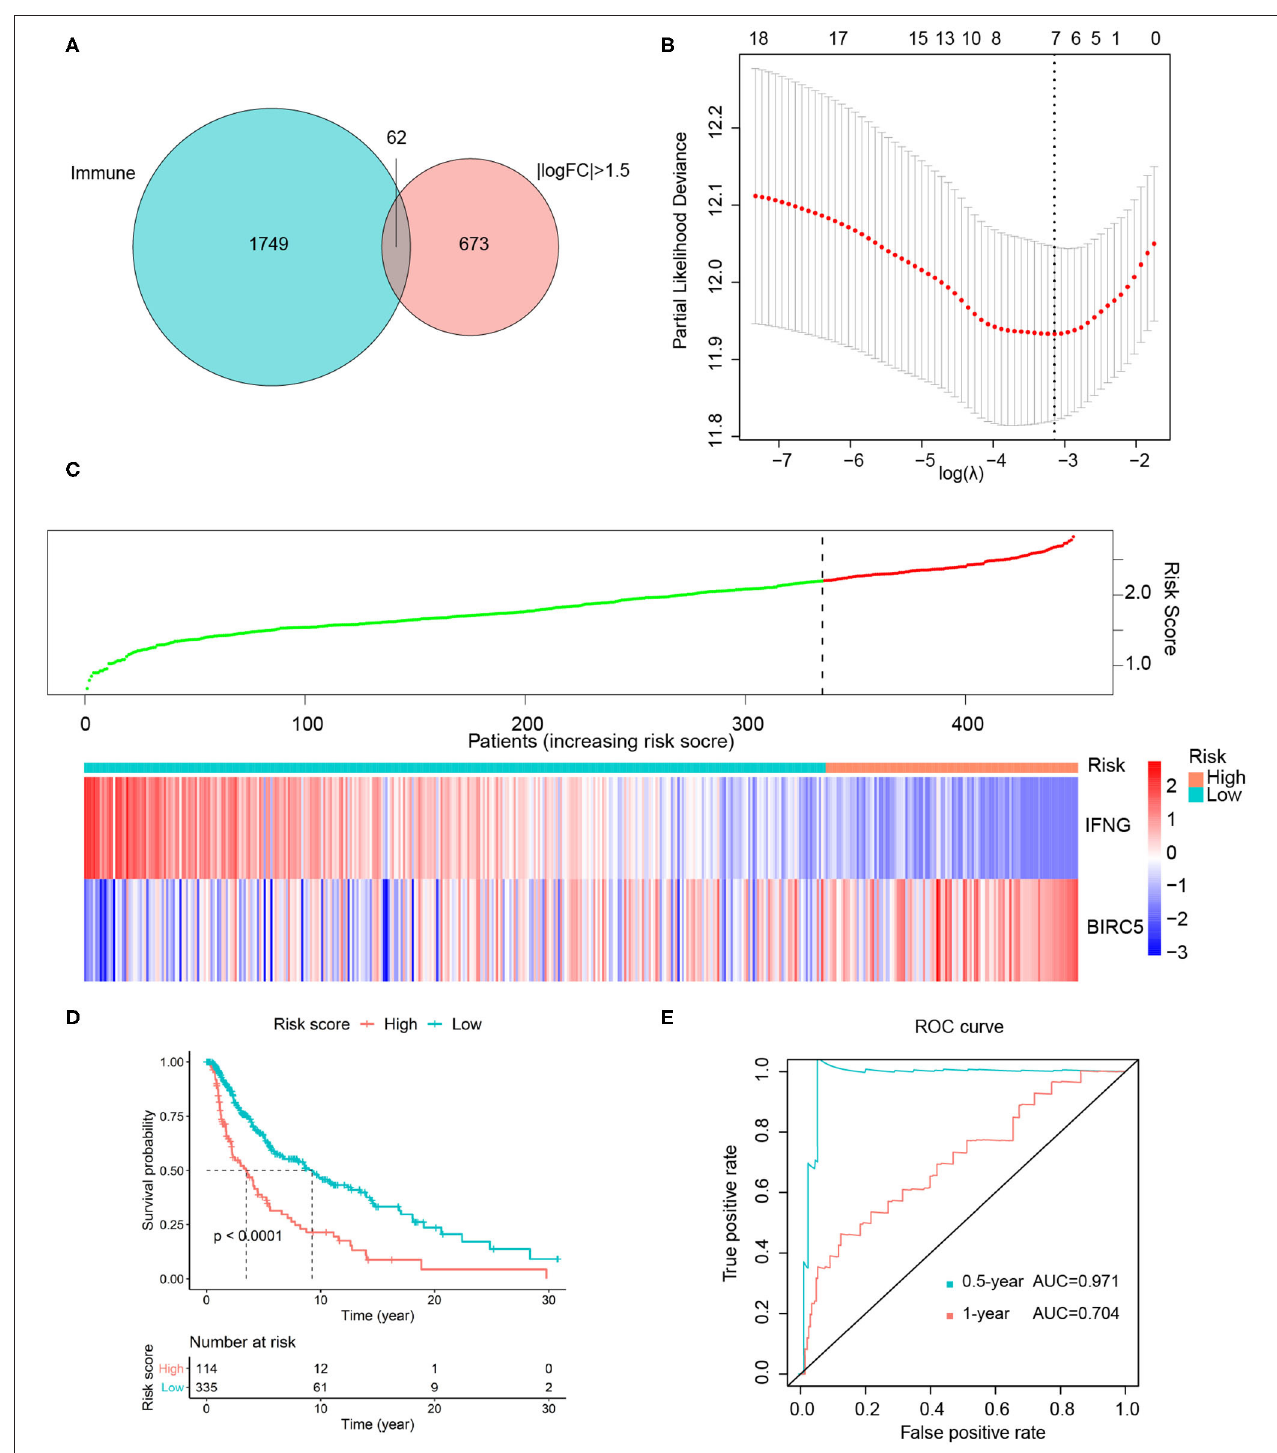
FIGURE 5 | Construction of risk score model. (A) Intersection of 735 DEGs and 1811 immune-related genes. (B) Seven genes were identified from 18 candidate genes using LASSO regression. (C) The distribution of risk score and gene expression levels among patients. (D) High-risk group Correlated with poor survival outcome, with P < 0.0001. (E) ROC curves of 0.5- and 1-year survival prediction, with AUC = 0.971 and 0.704, respectively. FC, fold change.